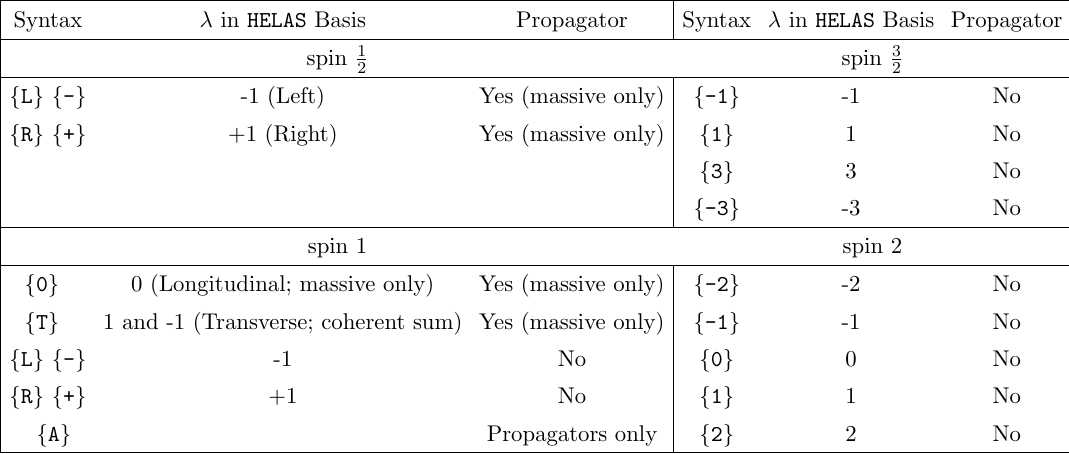
Table 5. For a given particle spin, the allowed mg5amc polarization syntax, its helicity state in the HELAS basis, and whether the polarization is transmitted through propagators of massive